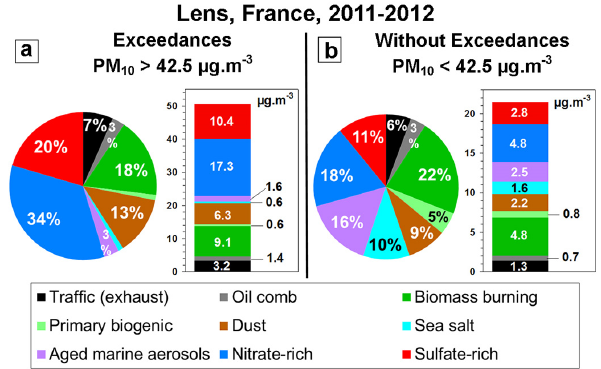
Fig. 10. Contributions of sources during exceedances (a) and for annual average (March 2011 to March 2012) without such ex- ceedances (b) in Lens in